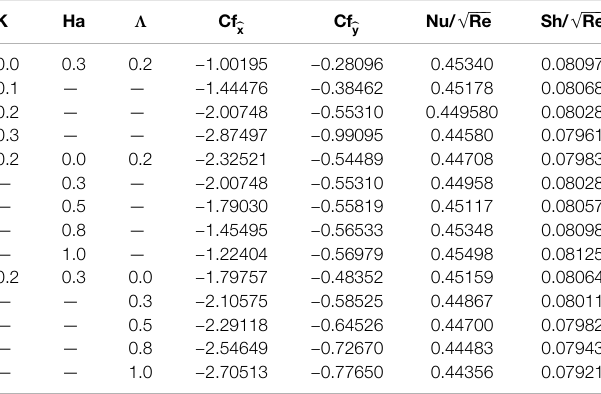
TABLE 4 | Variation of θ ( η ) for various combinations of Ha, R, and Hg for VENF and